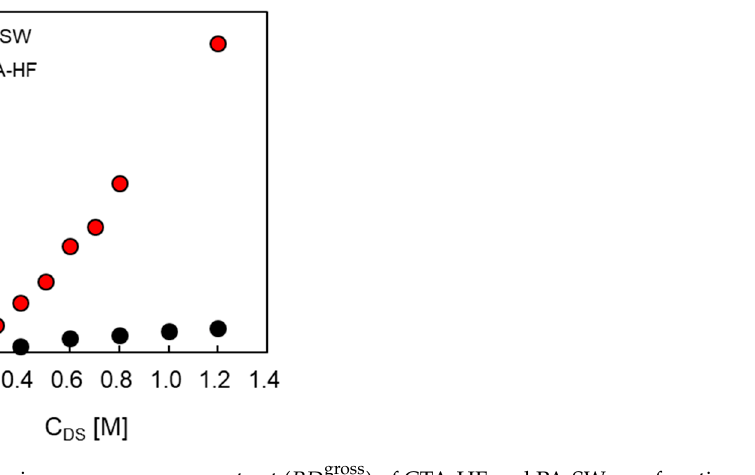
Figure 12. The maximum gross power output ( PD gross max ) of CTA-HF and PA-SW as a function of C DS . FS: treated tap water. Q DS: 10.0 L/min. Q FS : 5.0 L/min.